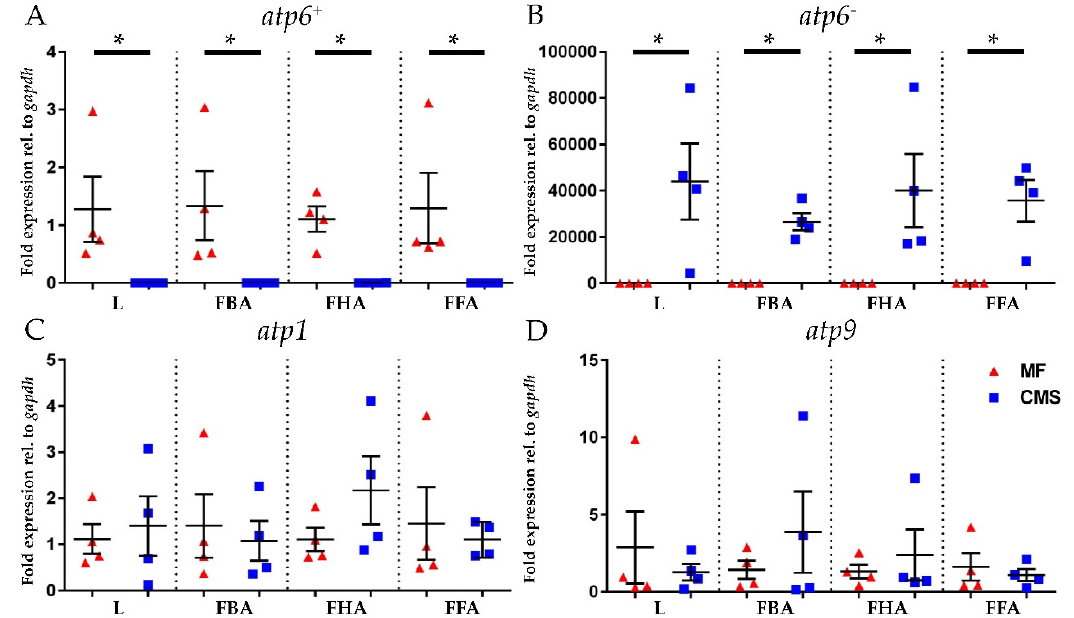
Figure 4. Evaluation of atp6 + ( A ), atp6 − ( B ), atp1 ( C ), and atp9 ( D ) mRNA expression by qPCR analysis. Expression analysis were conducted on male fertile (MF, n = 4, red triangles) and male sterile samples (CMS, n = 4, blue squares). Four di ff erent tissues were evaluated for each gene: leaf (L), flower before anthesis (0% flowering, FBA), flower in half anthesis (50% flowering, FHA) and flower in full anthesis (100% flowering, FFA). Ct values were normalized for gapdh . Statistical significance was evaluated with unpaired Student’s t -test (* p < 0.05). All data are shown as mean ±SD.